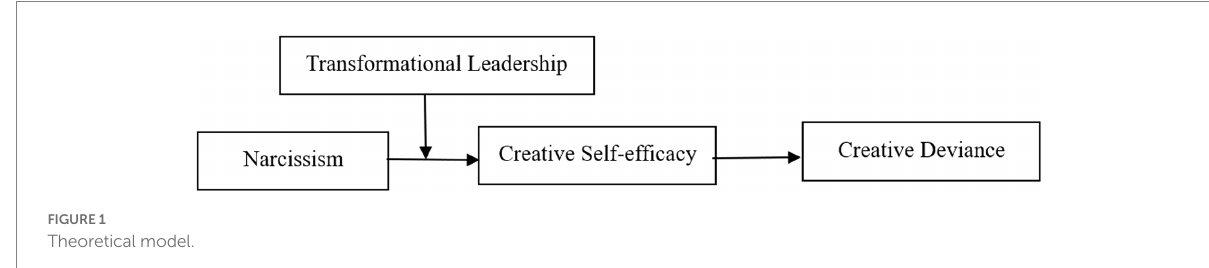
FIGURE 1 Theoretical